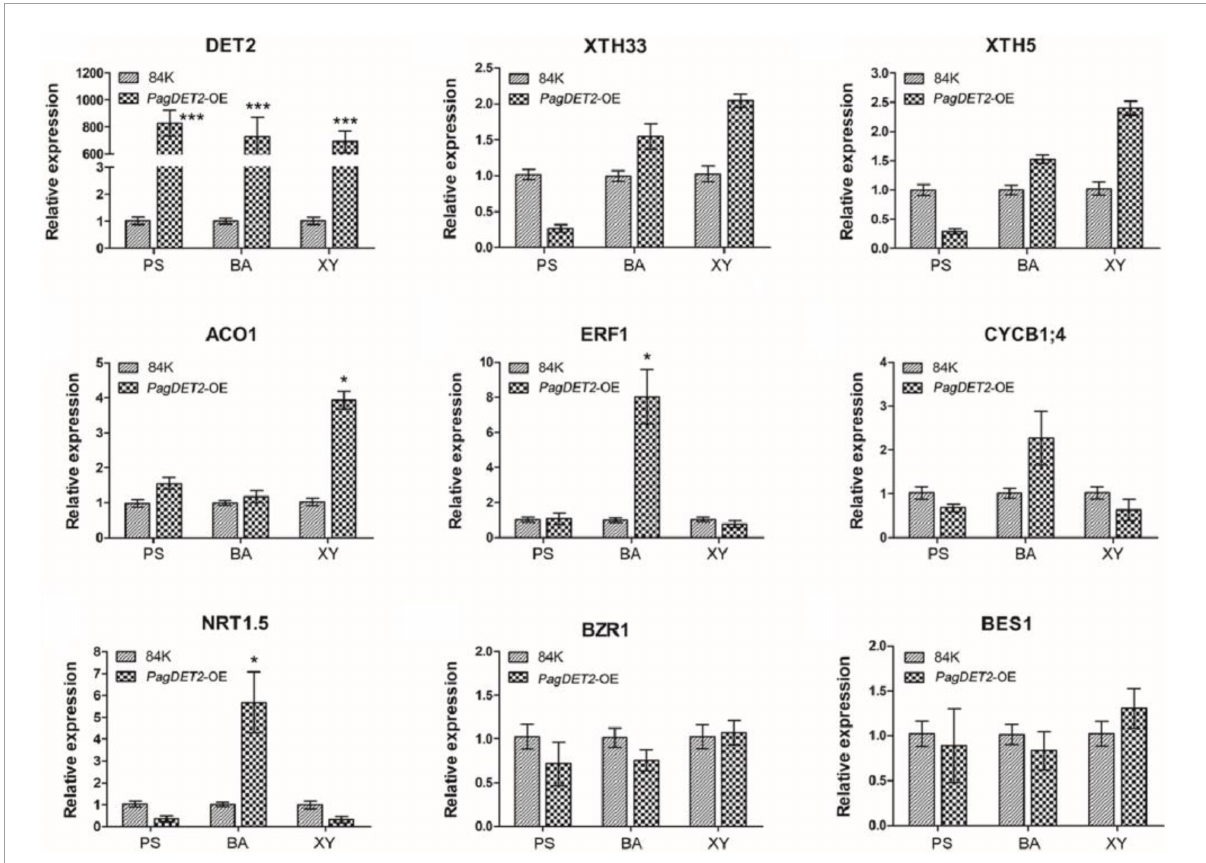
FIGURE7 Expression analysis of representative genes in the PS, BA, and XY domains of 84K wild-type and PagDET2 overexpression lines. PS, primary stem; BA, bark; XY, xylem. Mean ± SD. * and *** indicated significant difference at P < 0.05 and P < 0.001, respectively (Student’s t